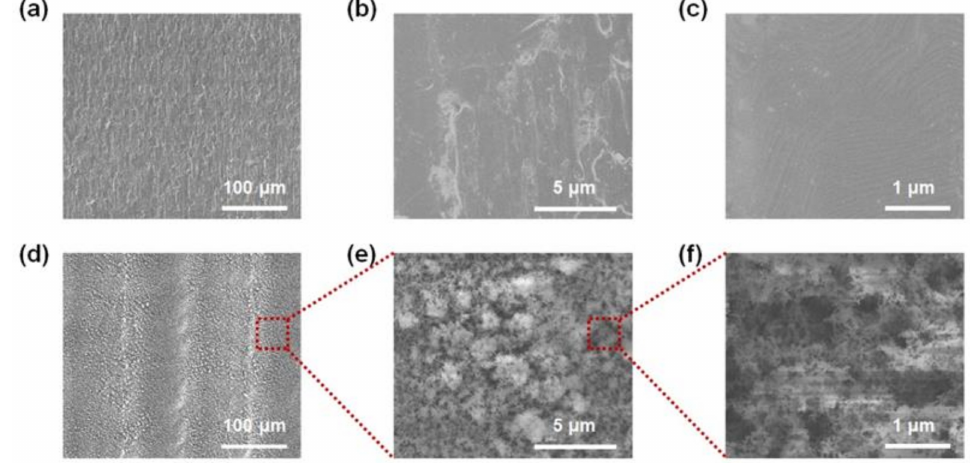
Figure 4. ( a – c ) SEM images of initial titanium alloy substrate. ( d – f ) SEM images of laser-treated titanium alloy substrate.